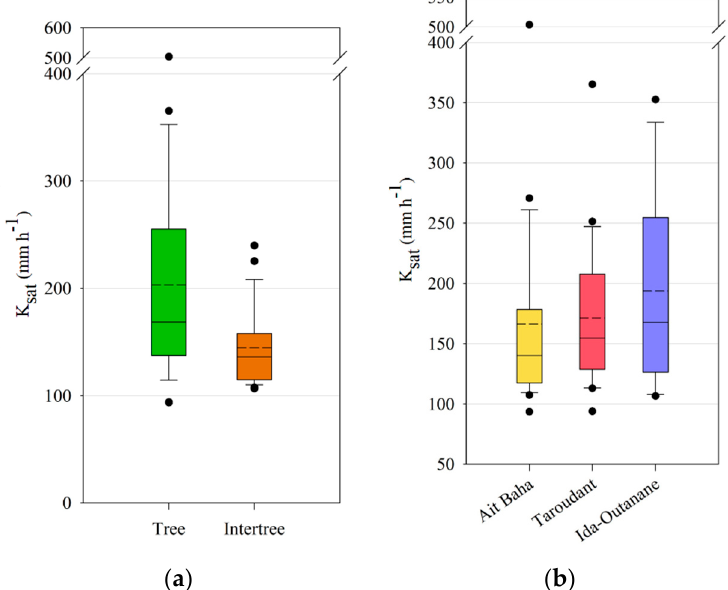
Figure 8. ( a ) Saturated hydraulic conductivity (K sat , p < 0.05) for tree and intertree areas as well as ( b ) for the three study areas (short dash: mean line, solid line: median, dots: outliers).